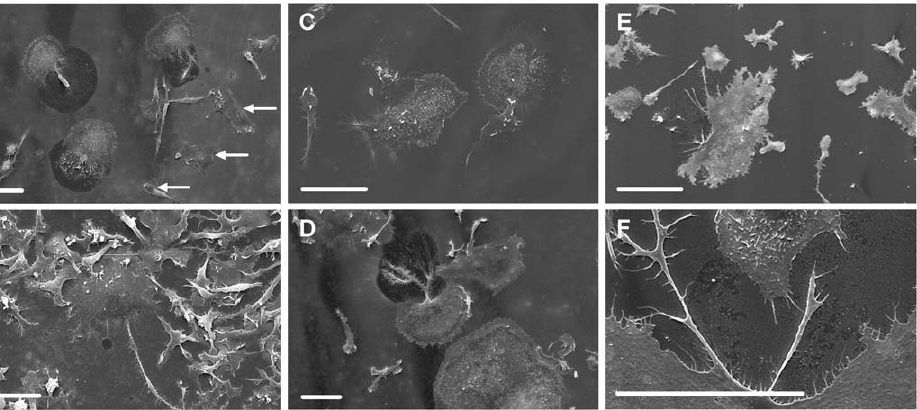
Figure 7. Vitronectin induces formation of resorption-like trails by osteoclasts on glass substrates. Osteoclasts were incubated for 5 hours in MEM/BSA with M-CSF (50 ng/ml), RANKL (30 ng/ml) and IL-1 a (10 ng/ml) (A, C–F), or M-CSF (B), together with the cathepsin inhibitor E64 (3 6 10 2 7 M) (C) or GM6001 (1.3 6 10 2 5 M) (D), on glass coverslips coated with vitronectin (A–D) or fibronectin (E, F) (50 m g/ml), before preparation for SEM. A: Osteoclasts incubated in resorption-inducing cytokines on vitronectin show well-defined cleared areas at the retreating margins of the cells. Macrophagic cells (some of which are identified by arrows, as the smaller cells, with leaf-like, rather than filopodial membrane folds) are not associated with cleared areas. B: Only occasional, and small, cleared areas were seen in cultures to which resorption-inducing cytokines had not been added. C: The formation of cleared areas was inhibited by the cysteine protease inhibitor E64. D: the MMP inhibitor GM6001 was without apparent effect. E, F: No cleared areas were seen at the retreating pole of osteoclasts incubated on fibronectin, although there was evidence of focal disturbance to the surface of the protein film in the region of filopodia. Scale bars =50 m m.